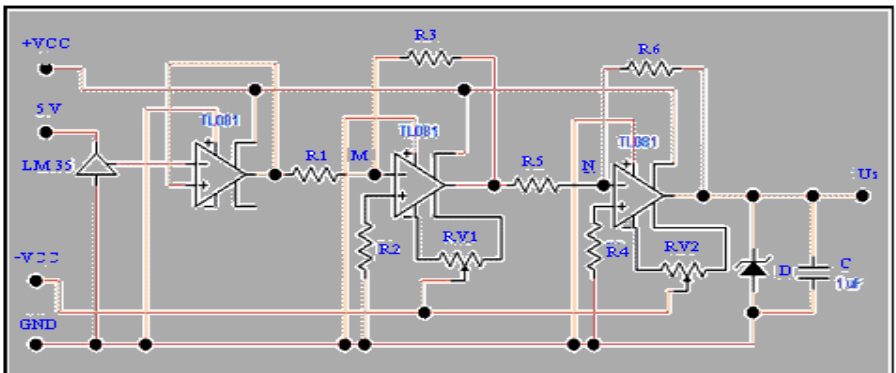
Figure 15. The temperature device